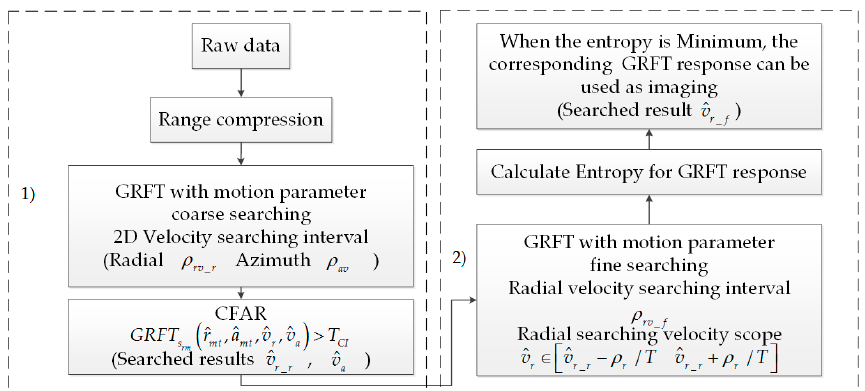
Figure 2. Flowchart of the moving ship target detection and imaging.